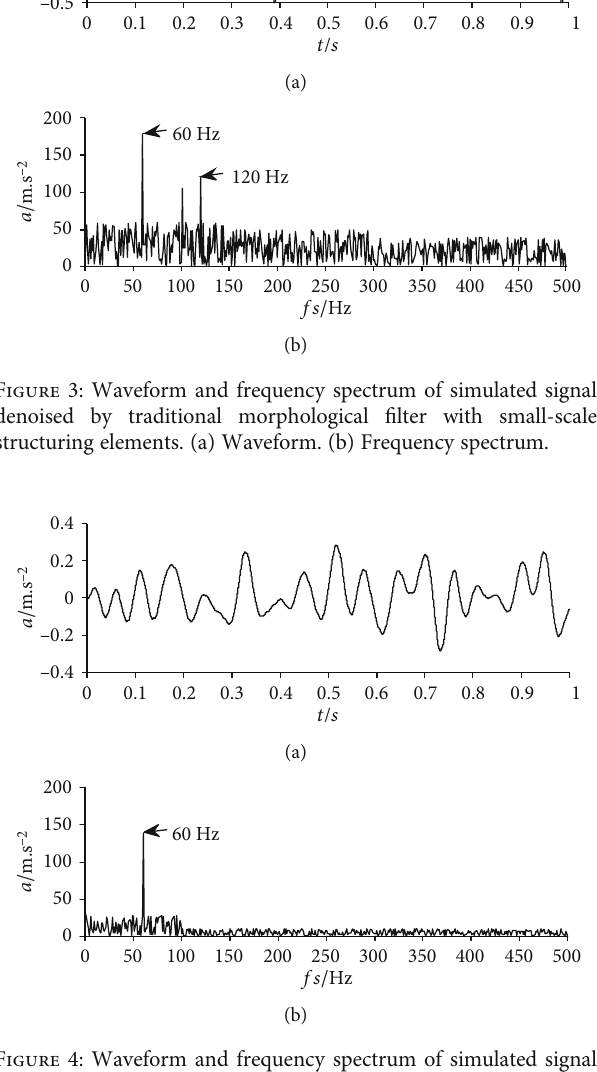
Figure 4: Waveform and frequency spectrum of simulated signal denoised by traditional morphological fi lter with large-scale structuring elements. (a) Waveform. (b) Frequency